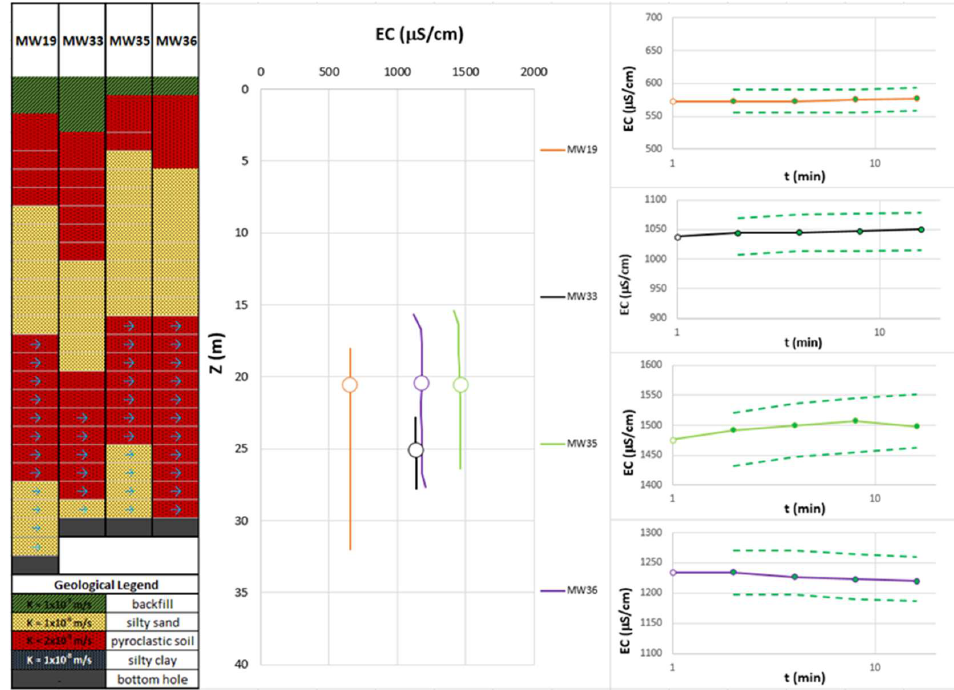
Figure 9. Layout of coupled log-purging (z-t) EC results for low-heterogeneity well types (MW19, MW33, MW35 and MW36).